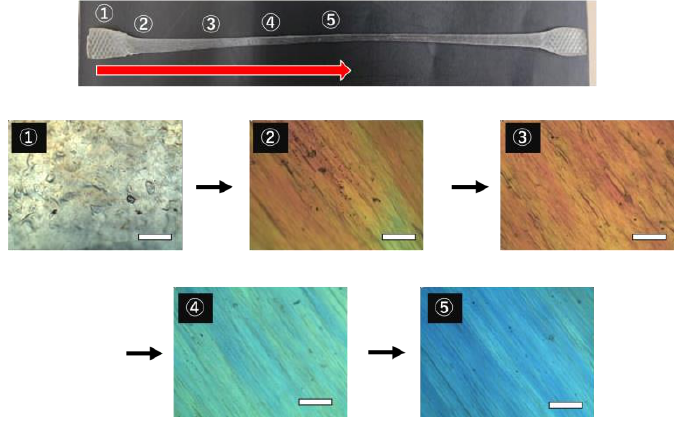
Figure 6. ( Top ) A photograph of a PDEF specimen after a tensile test. ( Bottom ) Polarizing optical images of the specimen at five different locations as pointed out in the photograph. The scale bars are 100 μm .